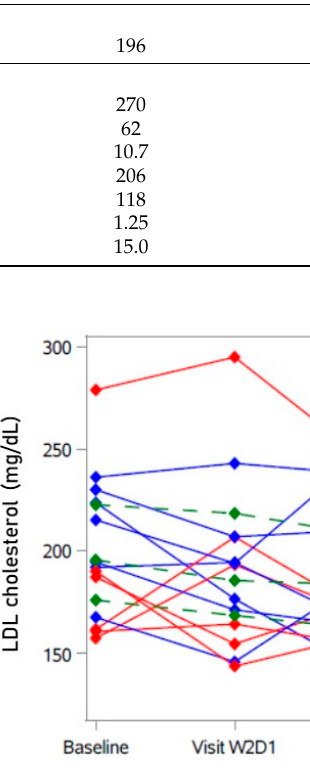
Figure 1. Course of LDL cholesterol under bulevirtide treatment in individual participants. Primary endpoint was change in LDL cholesterol after 12 weeks of treatment (Visit W13D1, highlighted): Participants with decrease of LDL cholesterol > 19.6 mg/dL in blue (“responder”); participants with no decrease and decrease < 19.6 mg/dL of LDL cholesterol in red (“non-responder”). Green: Hodges–Lehmann estimator with 95% confidence interval. Table 2. Baseline lipid profile and changes in lipid profile after 12 weeks of treatment with